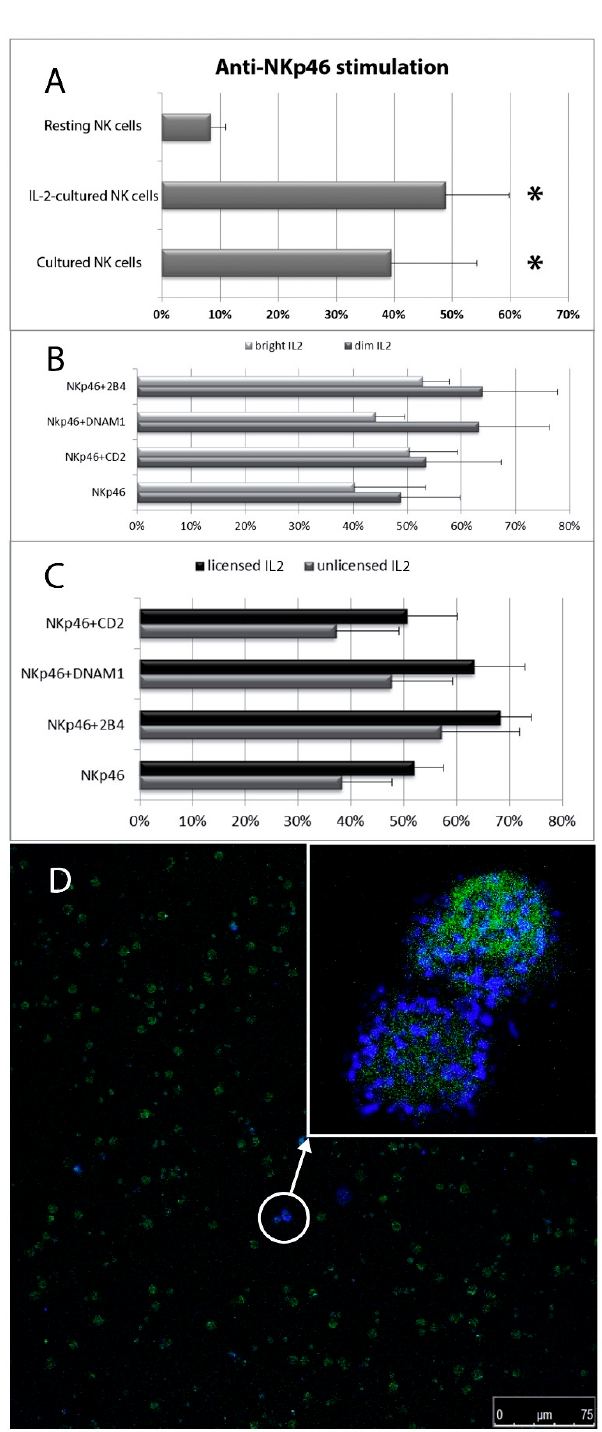
Figure 5. Degranulation analysis of in vitro cultured NK cells. ( A ) NK cell degranulation percentages induced by anti-NKp46 stimulation under three different culture conditions. ( B ) Degranulation percentages of IL-2-cultured NK cells stimulated with various mAb combinations was evaluated by comparing CD56 dim and CD56 bright degranulating NK cells or ( C ) licensed vs. unlicensed CD56 dim degranulating NK cells. Data represent mean +/- SD of at least 5 experiments. * p < 0.05 relative to resting NK cells stimulated with anti-NKp46 mAb-coated beads. ( D ) Confocal microscopy observation of NK cell degranulation on CD45 + (green) PBMCs stimulated with anti-NKp46 plus anti-2B4. A di ff use labelling pattern. No relevant polarization of CD107a (blue) is detectable on degranulating NK